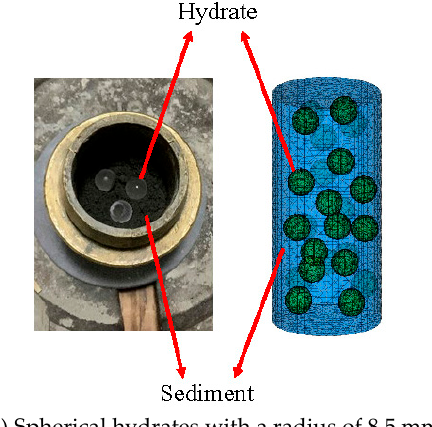
Figure 5. Test sample and model diagram.